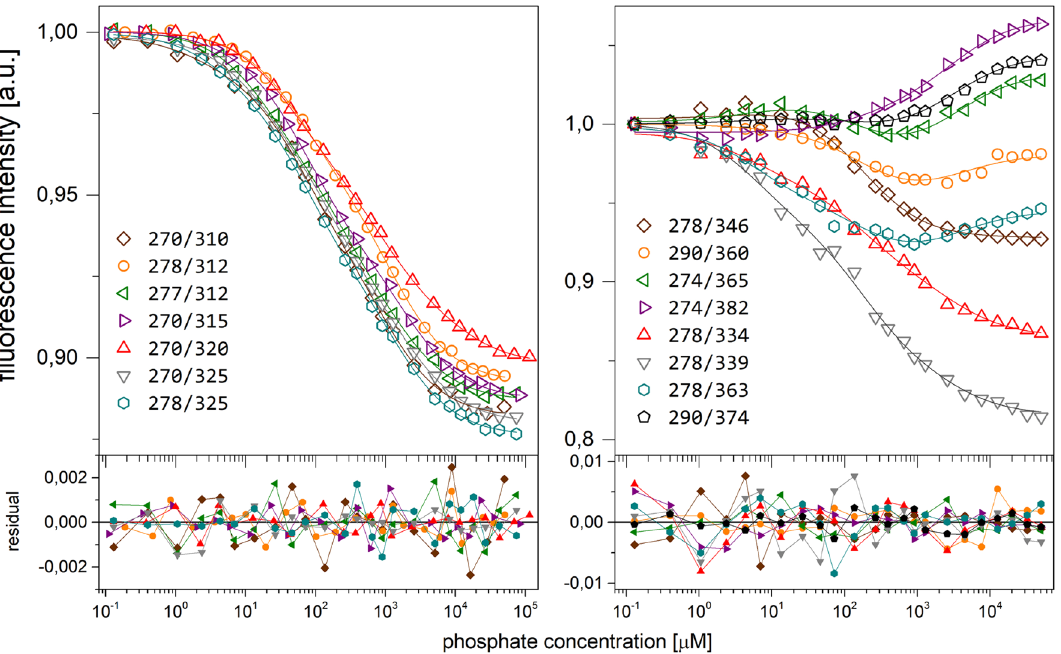
Figure 4. Fluorescence titration curves of the enzyme with phosphate: WT (left panel) and Y160W mutant (right panel). Data (points), global best fit model (lines) and residual plots are presented. Titrations were performed at 25 °C, in 50 mM Tris/HCl buffer pH 7.6 and in following excitation/observation wavelengths for the WT enzyme: 270/ 3 10 nm (brown), 278/ 3 12 nm (orange), 277/ 3 12 nm (green), 270/ 3 15 nm (violet), 270/ 3 20 nm (red), 270/ 3 25 nm (grey), 278/ 3 25 (blue); and for the Y160W mutant: 278/346 nm (brown), 290/360 nm (orange), 274/365 nm (green), 274/382 nm (violet), 278/334 nm (red), 278/339 nm (grey), 278/363 nm (blue), 290/374